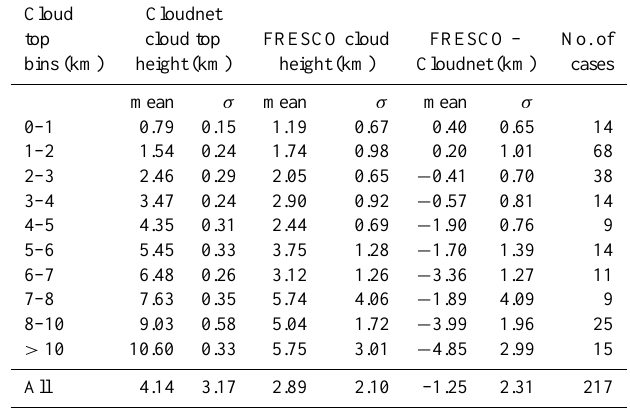
Table A2. Comparison of ESA L2 cloud top height with Cloudnet cloud top height for single-layer clouds. Cloud Cloudnet ESA L2 cloud top bins top height top height ESA L2 – No. of (km) (km) (km) Cloudnet (km) mean σ mean σ mean σ